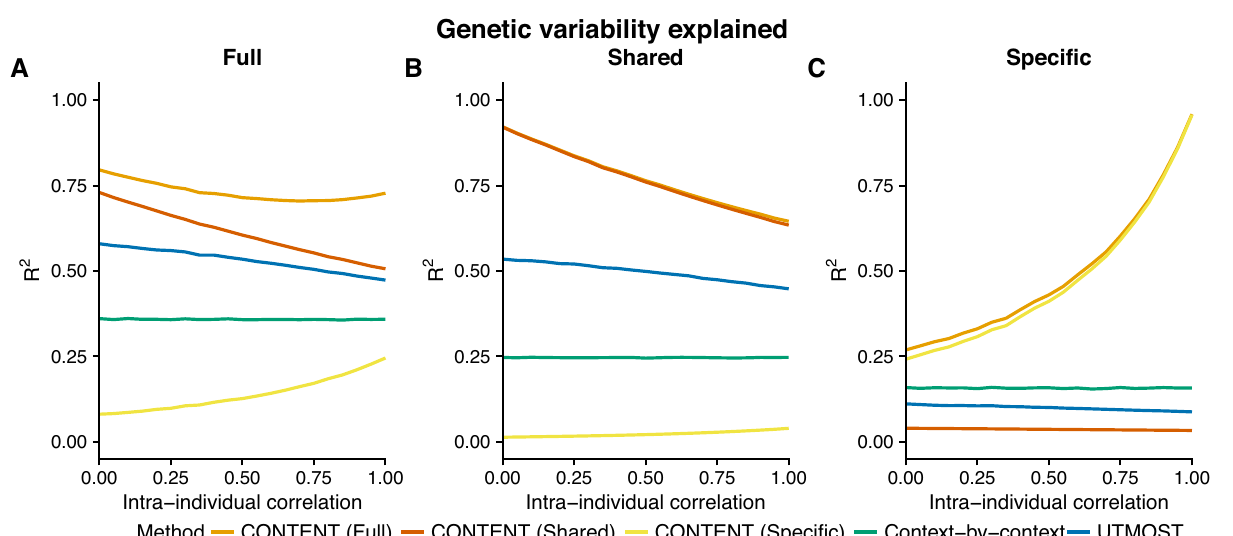
Fig.2|CONTENTispowerfulandwell-calibratedinsimulateddata. Accuracyof each method to predict the genetically regulated gene expression of each gene- context pair for different correlations of intra-individual noise across contexts. Mean adjusted R 2 across contexts between the true ( A ) full (context-speci fi c+ context-shared), B shared,and( C )speci fi cgeneticcomponentsofexpressionand